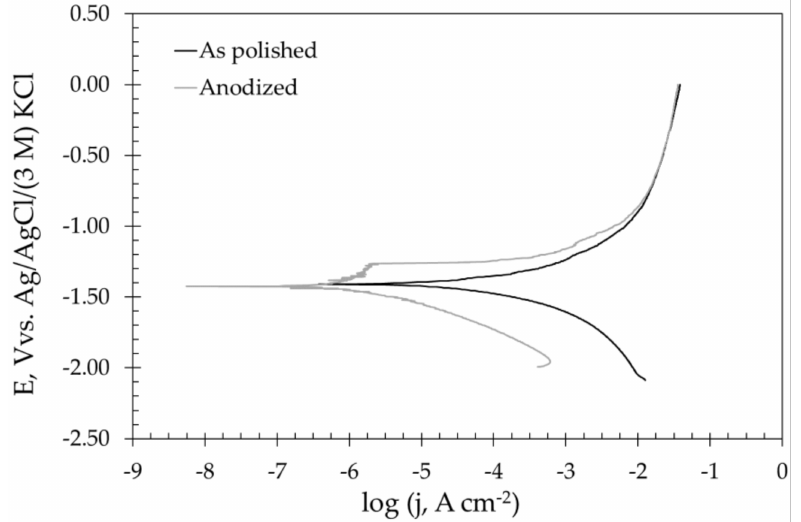
Figure 2. SEM images of the anodized layer ( a ) top surface and ( b ) cross-section. Potentiodynamic polarization curves of the polished and anodized samples tested in PBS solution at room temperature are presented in Figure 3. The values of corrosion potential ( E corr ) and corrosion current densities ( j corr ) were determined from the curves using the Tafel extrapolation method. The results are shown in Table 1. The j corr values were significantly affected by the presence of the anodic film. The dissolution rate of the anodized sample was reduced by one order of magnitude. The anodized layer acted as a barrier layer against electrolyte penetration. However, as seen in Table 1, the produced oxide layer presents an inherent porosity, which could be related to the cracks and cavities observed from the SEM micrographs (Figure 2).